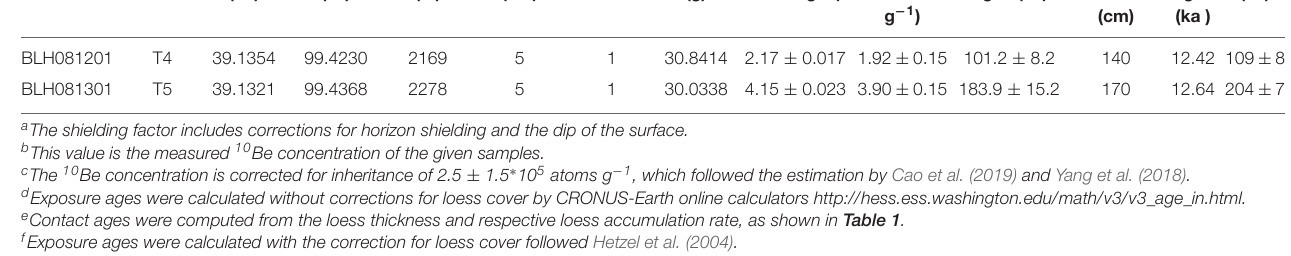
TABLE 2 | 10 Be samples and analysis results for terraces of the Bailang River. Sample Sample Latitude number location (N ◦